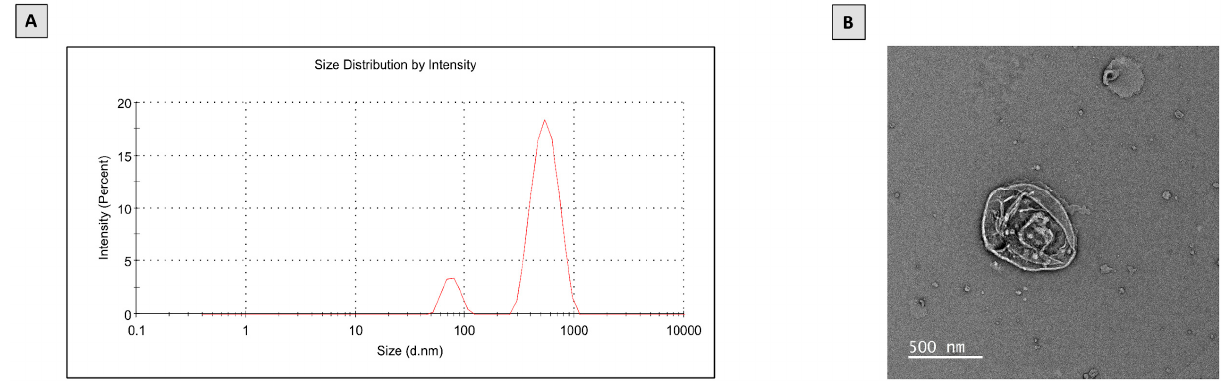
Figure 1. Characterization of PTL-phytosomes. ( A ) Particle size distribution, ( B ) TEM image.